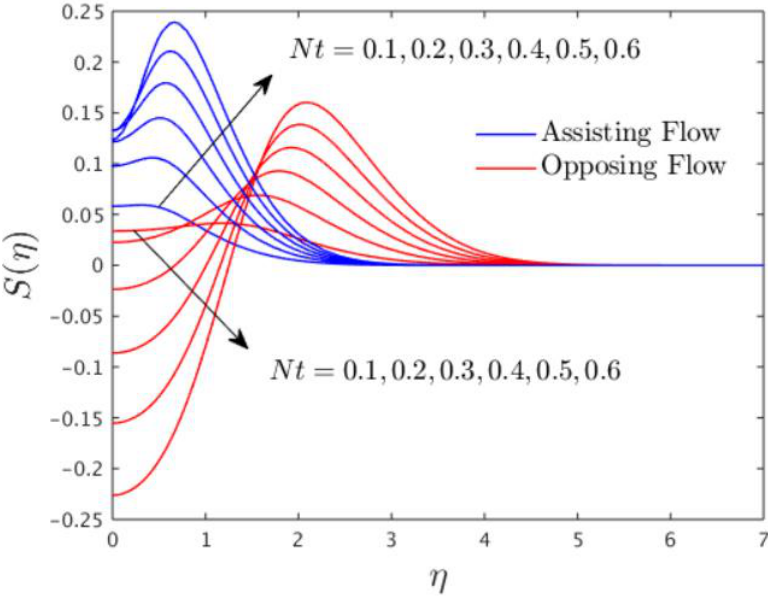
Figure 9.   S  against Nt .